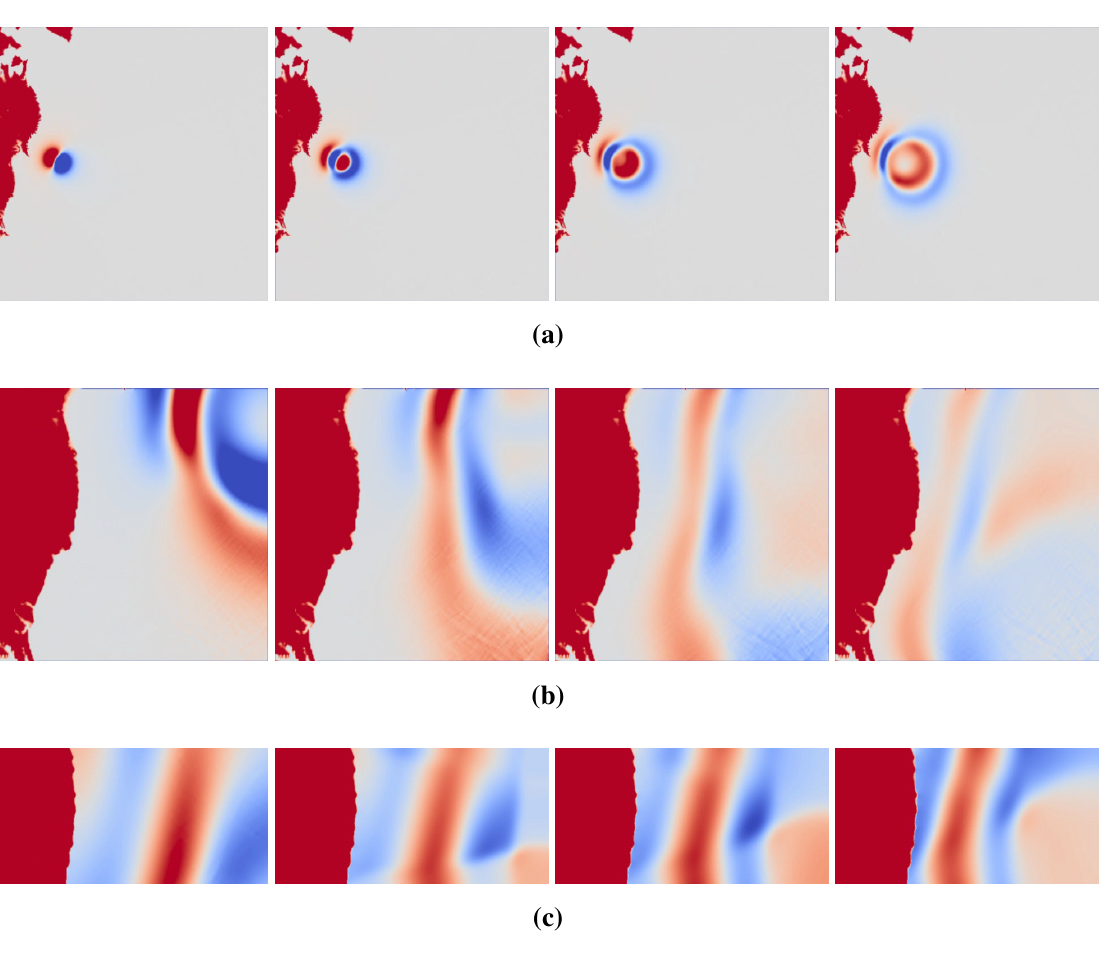
Figure 10. Results on three of the four consecutively-refined grids. ( a ) Grid Level I; ( b ) Grid Level II; ( c ) Grid Level